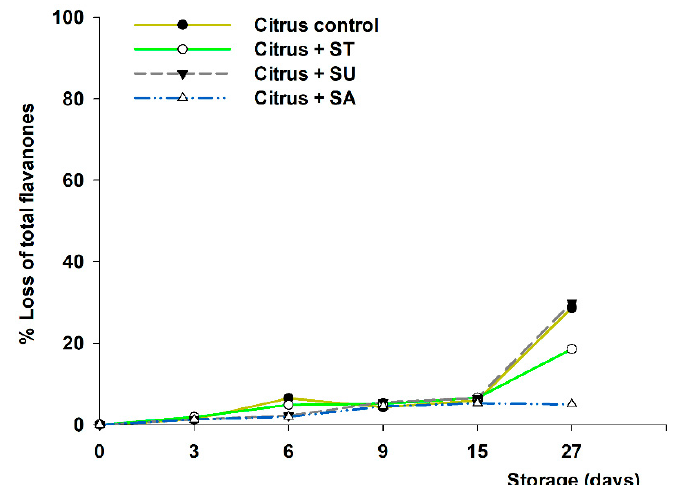
Figure 2. Percentage of loss of total flavanones ( A ) and anthocyanins ( B ) in citrus–maqui beverage samples (control without sweeteners), and citrus–maqui beverage samples plus sweeteners, stevia (ST), sucralose (SU), or sucrose (SA), measured during 27 days at 4 °C. Significantly different final concentration absolute values according to statistical analysis (ANOVA and Tukey’s multiple rank test) were found at p < 0.05, for both figures.